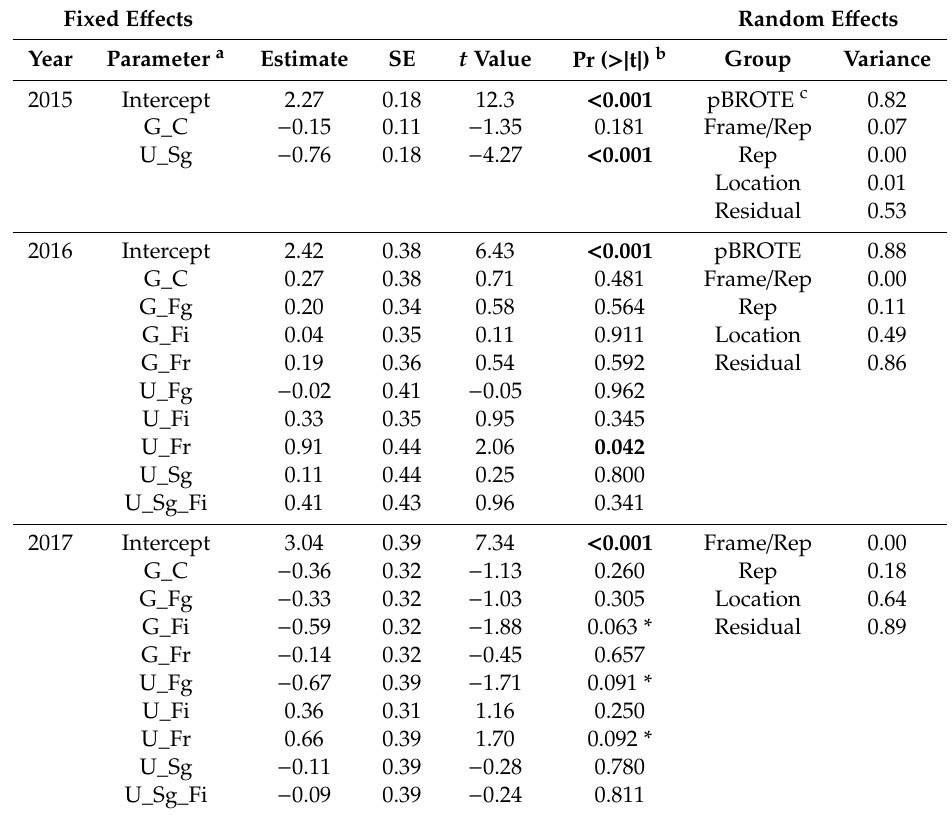
Table 2. The response of Bromus tectorum biomass to grazing and / or herbicide treatments, analyzed using a linear mixed e ff ects model. All treatments (parameters) are with respect to the ungrazed control treatment (U_C), which is the intercept in the model. In 2015 only the grazed (G) and ungrazed control, and the spring applied herbicide treatment results are shown, because fall herbicide application had not yet occurred. Results are based on log transformed B. tectorum biomass.